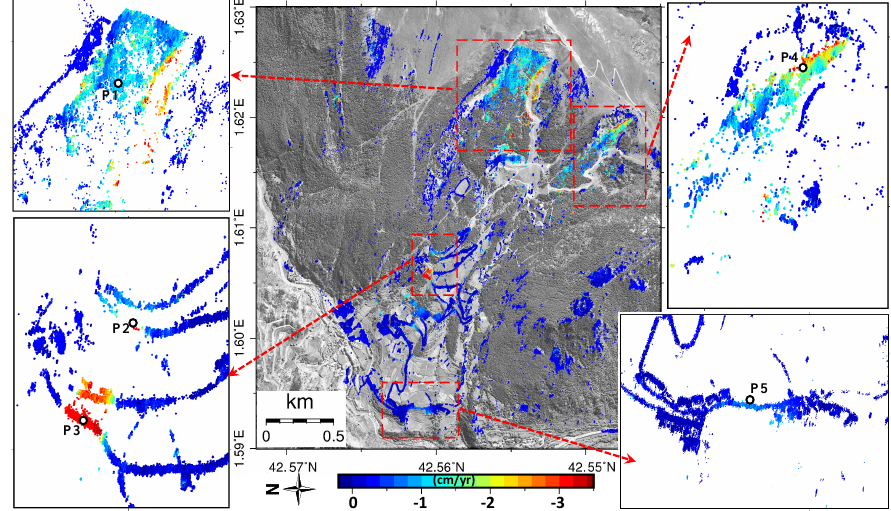
Figure 12. Down-slope displacement velocity map derived by the TPC method. Estimated displacement velocities within subareas A, B, C and D in Figure 8 have been enlarged for a better visualization with a white background. The locations of points P1–P5 in the subareas, which are further analyzed in the text, have also been